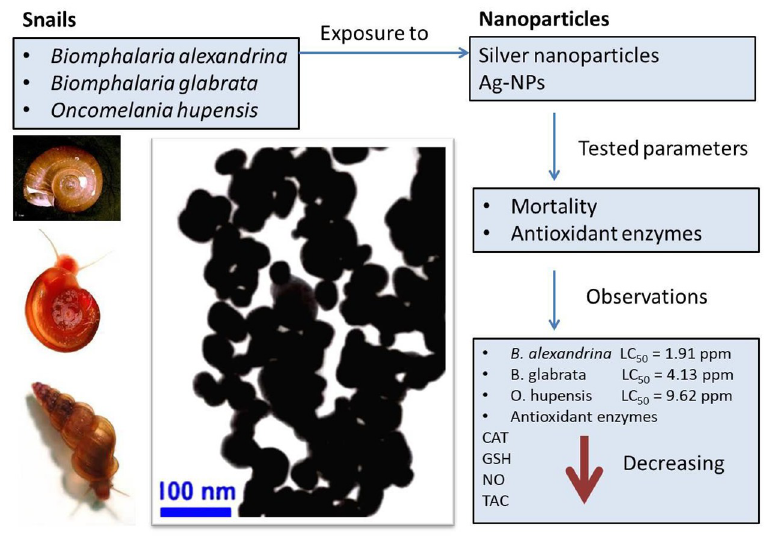
Fig 3. Graphical